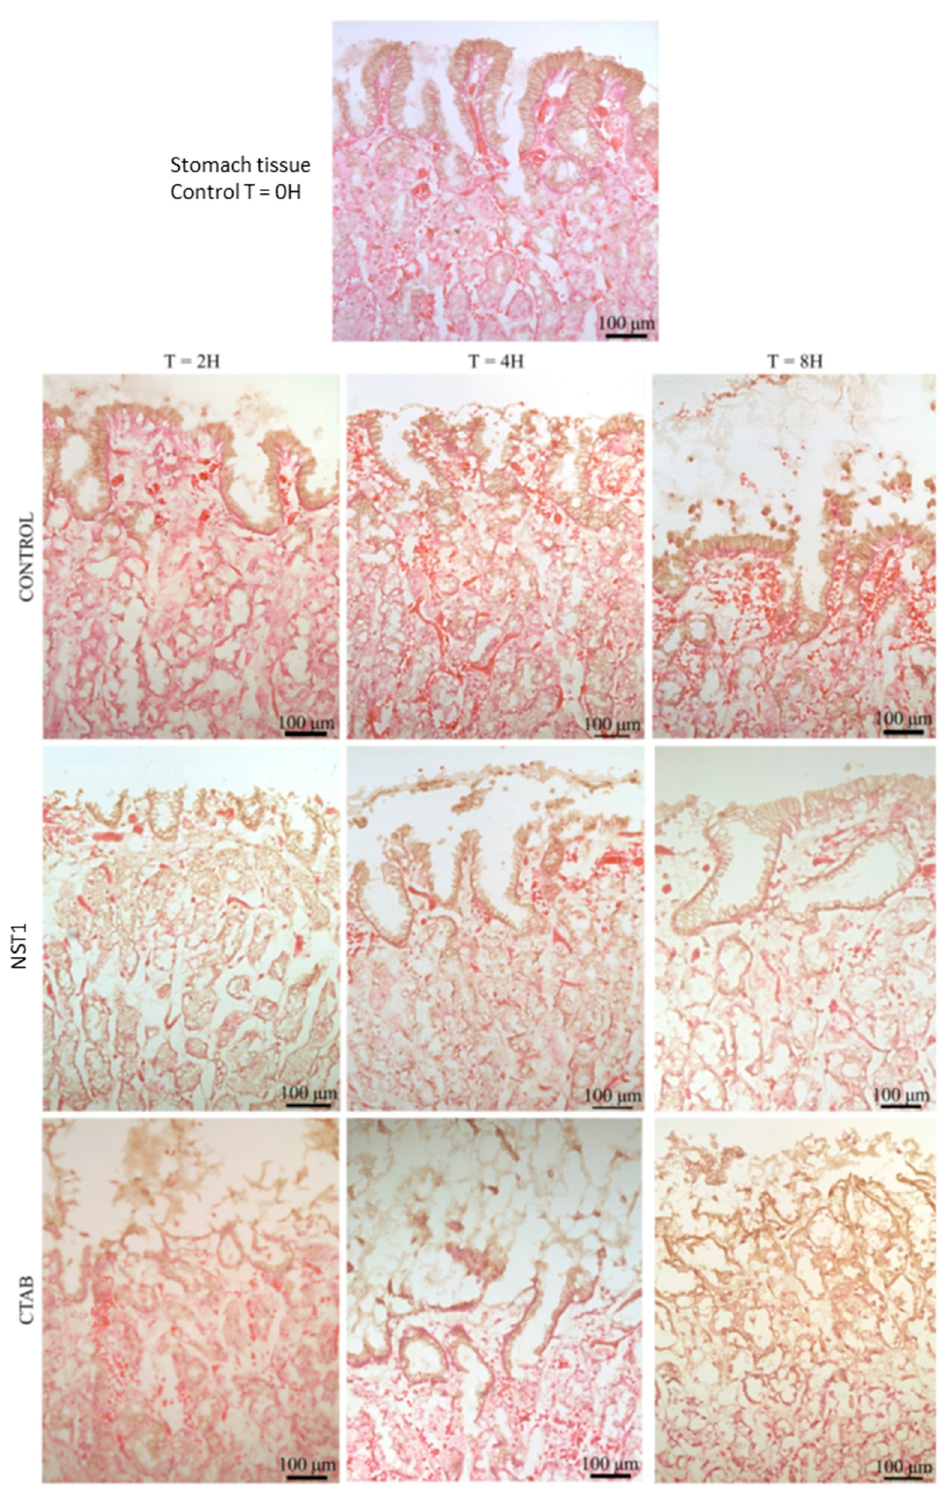
Figure 11. Histological examination of human stomach tissue treated with NST1. Human gastric explants were treated with NST1 (100 µ M) or CTAB (300 µ M) as positive control of tissue damages for 2, 4, 8 h before H&E staining and microscopic observations as explained in Materials and Methods. Images shown are representative of effects observed in triplicate.